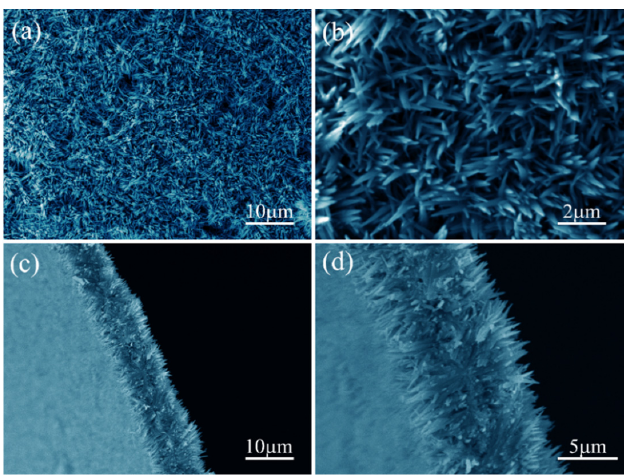
Figure 1. SEM images of TiO 2 nanoarrays grown on vertically placed FTO substrate: ( a ) Front view of TiO 2 nanoarray; ( b ) A magnified view; ( c ) TiO 2 nanoarray cross-section; ( d ) C magnified view.